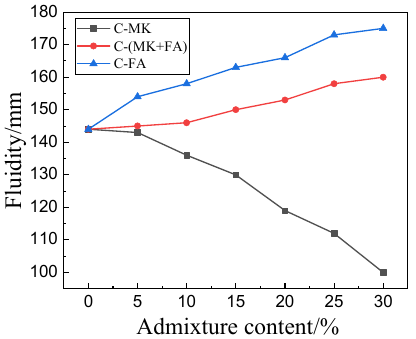
Figure 2. Fluidity of MOSC with different admixtures and admixture amounts.